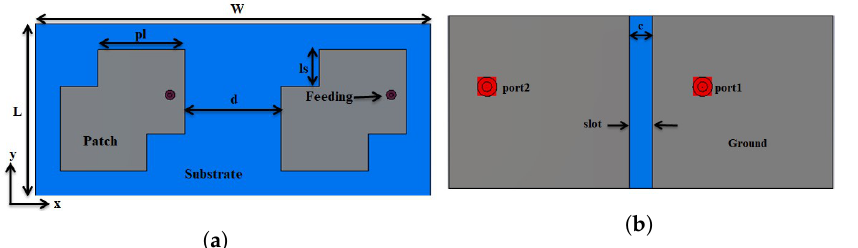
Figure 2. ( a ) Corner square-cut shape of the MIMO antenna circular polarization front view; ( b ) MIMO antenna back view.